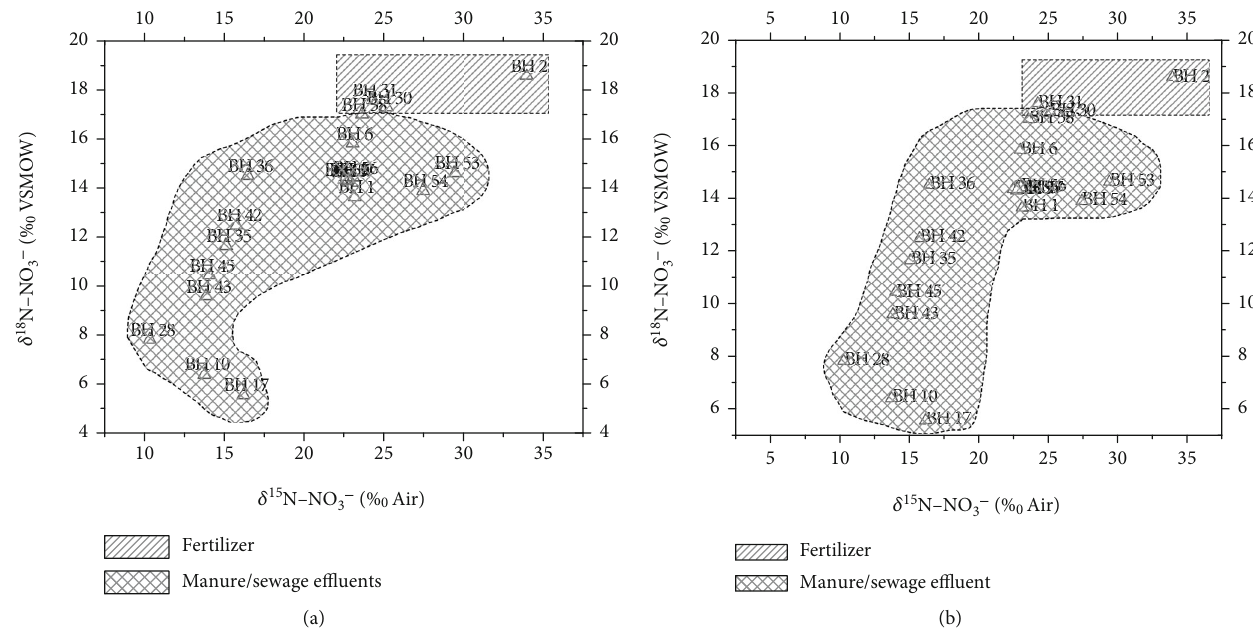
Figure 11: Dual-isotope signatures in boreholes during the (a) wet and (b) dry